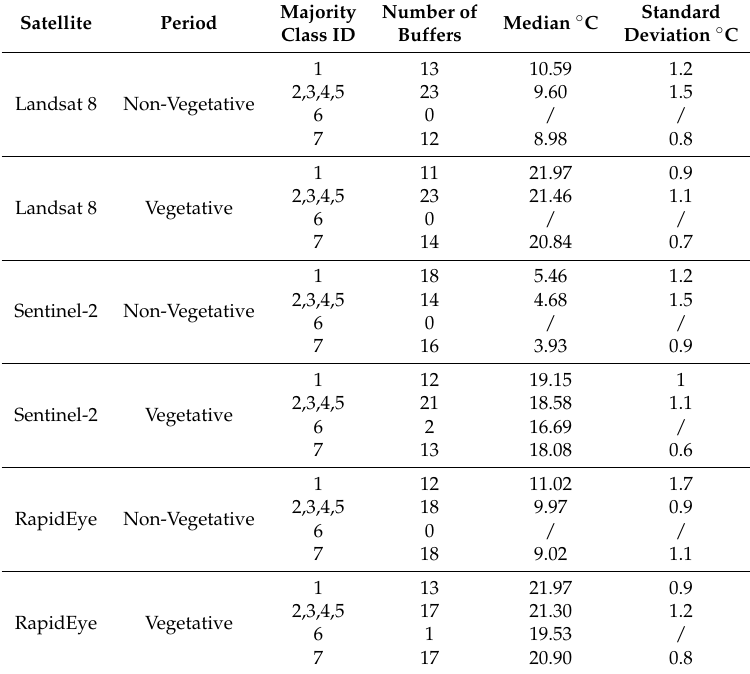
Table 5. Results of LCZ classes effects on air